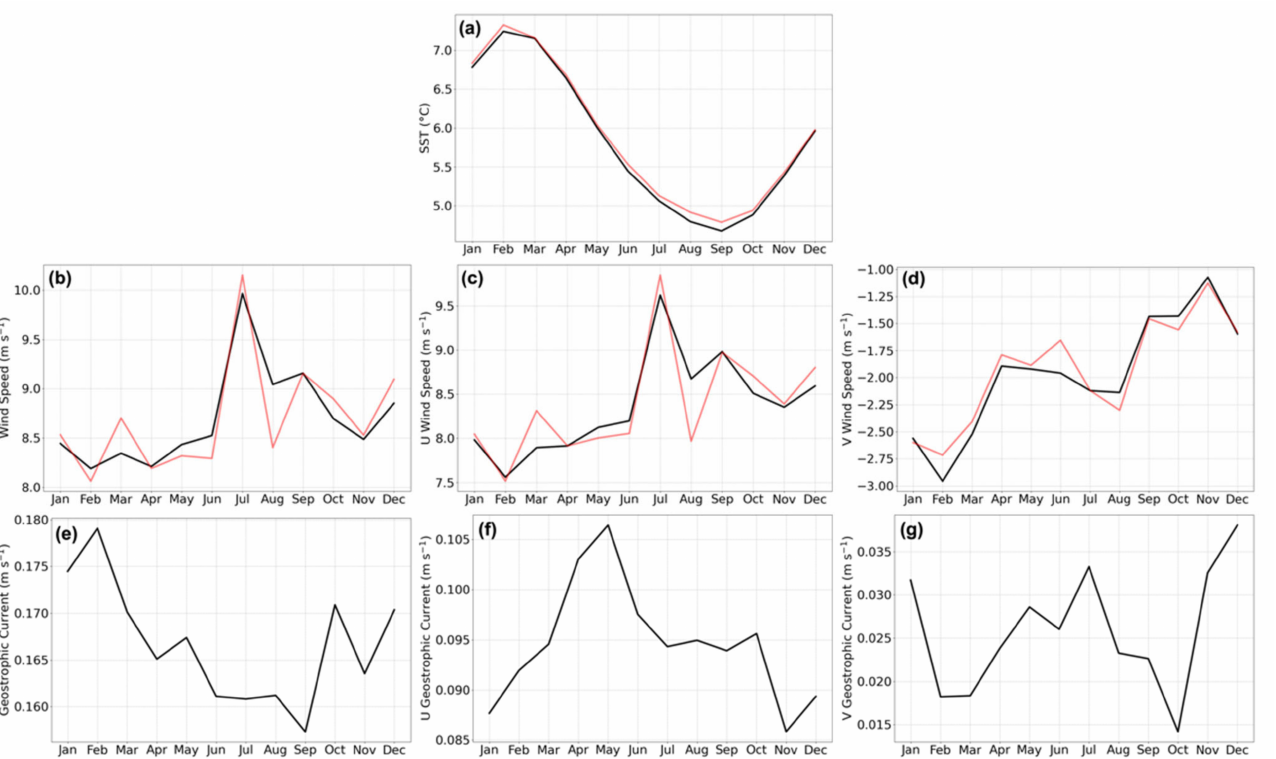
Figure 2. The monthly climatology of the ( a ) 1982–2020 (black) and 1993–2016 (red) Sea Surface Temperature (SST); ( b ) 1979–2020 (black) and 1993–2016 (red) wind speed; ( c ) 1979–2020 (black) and 1993–2016 (red) zonal (U) wind speed component; ( d ) 1979–2020 (black) and 1993–2016 (red) meridional (V) wind speed component; ( e ) 1993–2016 geostrophic current speed; ( f ) 1993–2016 zonal (U) geostrophic current speed component; and ( g ) 1993–2016 meridional (V) geostrophic current speed component, averaged within the 2 ◦ × 2 ◦ area around the Prince Edward Islands.